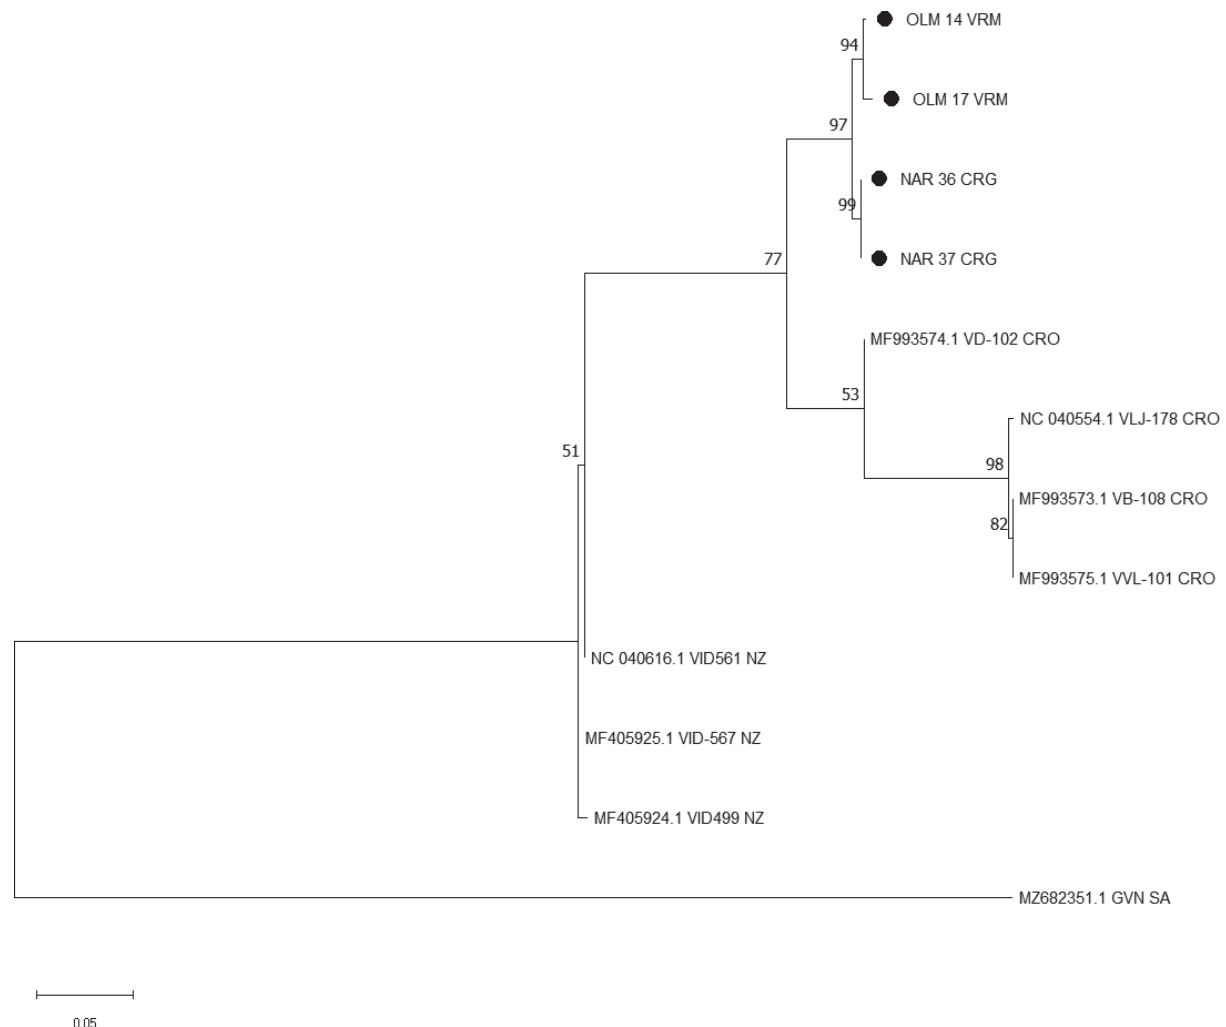
Figure 1. Phylogenetic tree generated from partial nucleotide sequences of the CP region of GVG isolates. Bootstrap values were obtained using 1000 replicates. Only branches with support greater than 50% are indicated. Sardinian isolates detected in this study are indicated by black dots. The phylogenetic tree was reconstructed using the maximum likelihood algorithm implemented in MEGA X software. Four isolates from Croatia (CRO) and three from New Zealand (NZ) were selected from the GenBank database. The GVN sequence (MZ682351) was used as the rooting